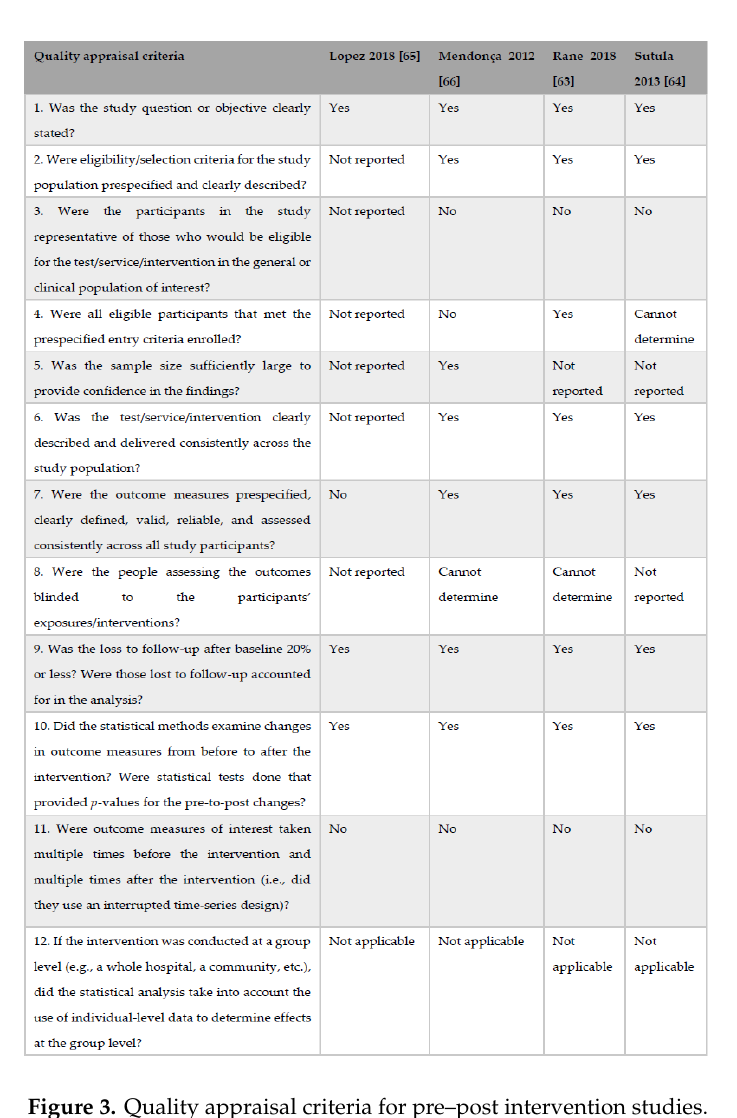
Figure 3. Quality appraisal criteria for pre–post intervention studies.